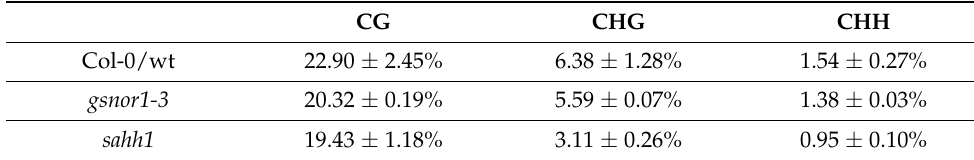
Table 2. Mean methylation rates per context (± SD) as analyzed by WGBS ( n =2). Mean methylation rates in CG, CHG, or CHH context (H = A, C, or T) in Col-0/wt, sahh1 , and gsnor1-3 were calculated from cytosines that were covered by at least 5 reads.